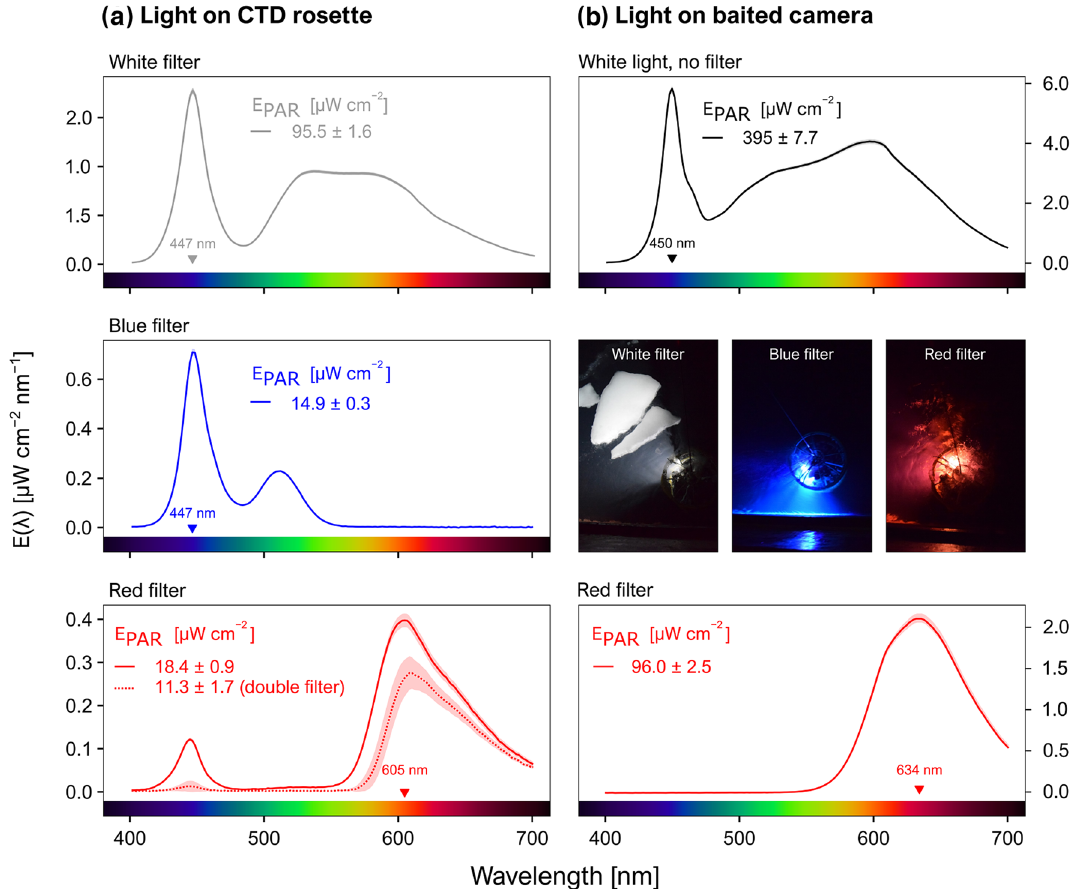
Figure 2. Spectral irradiance E(λ) in the range 400–700 nm, with and without different coloured filters, for the light sources mounted to ( a ) the acoustic probe and ( b ) the baited camera system. Lines show averages across triplicate measurements, with standard deviations given as envelopes. The wavelength of peak irradiance is indicated in each panel. E PAR values are provided with standard deviations from triplicate measurements. Pictures of the rosette with different light colours just below the surface and taken from the Helmer Hanssen on January 2020 are